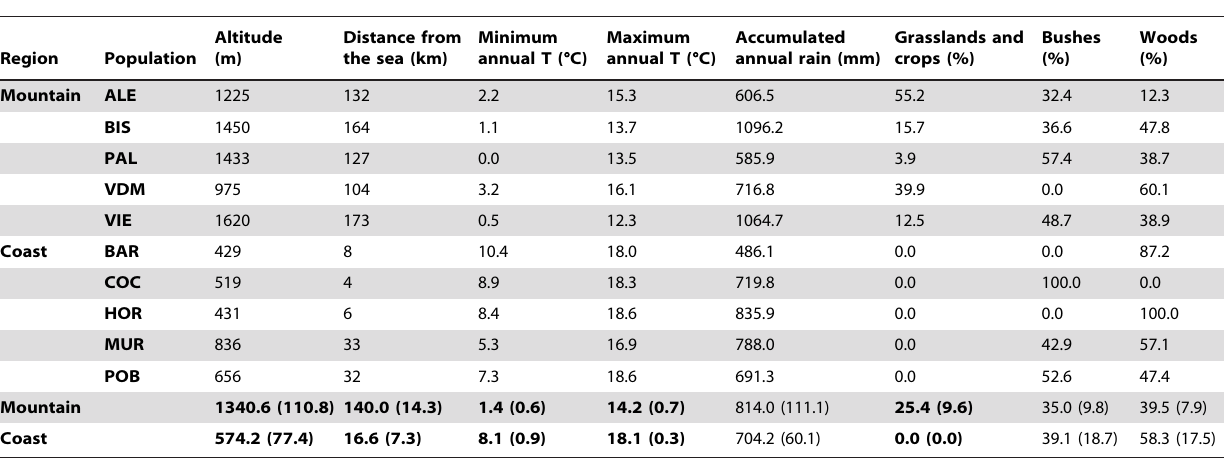
Table 1. Environmental parameters of A. thaliana populations.